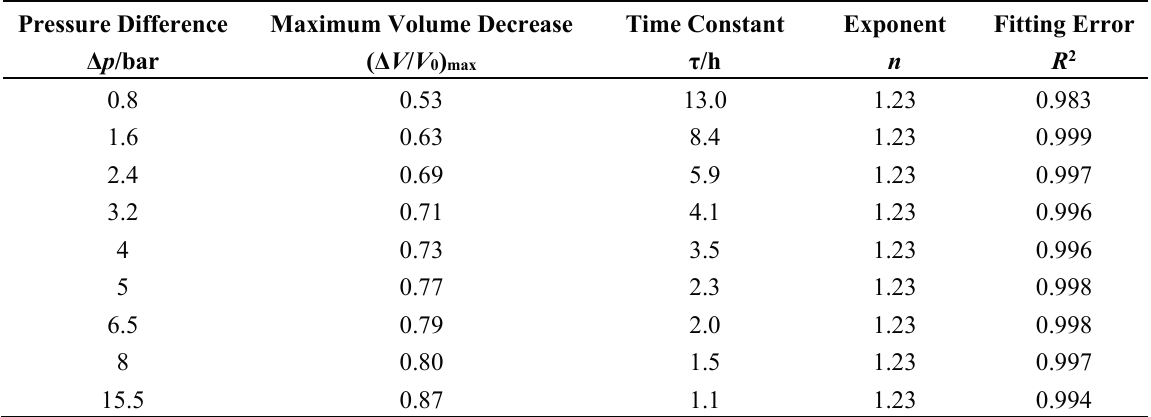
Table 2. Fitting parameters and fitting errors of the empirical equation for enforced syneresis, ϑ = 20 °C. Pressure Difference